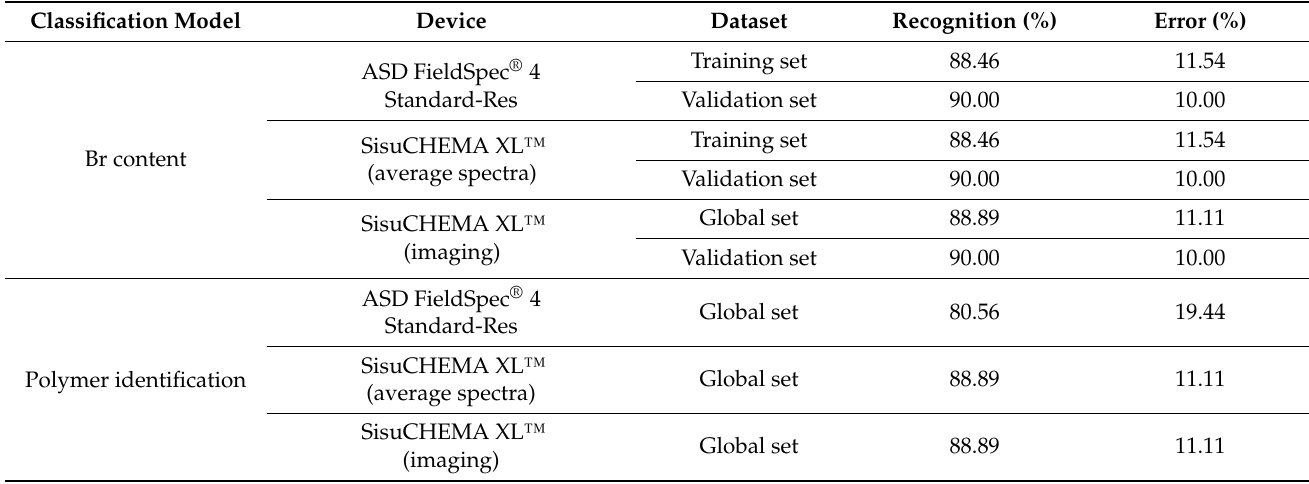
Table 7. Overall classification model performances. Calculations were performed applying an object-based recognition logic that was assuming a discriminating threshold of more than three out of five spectra for a punctual analysis and of 50% or more pixels correctly assigned for the hyperspectral approach, respectively.